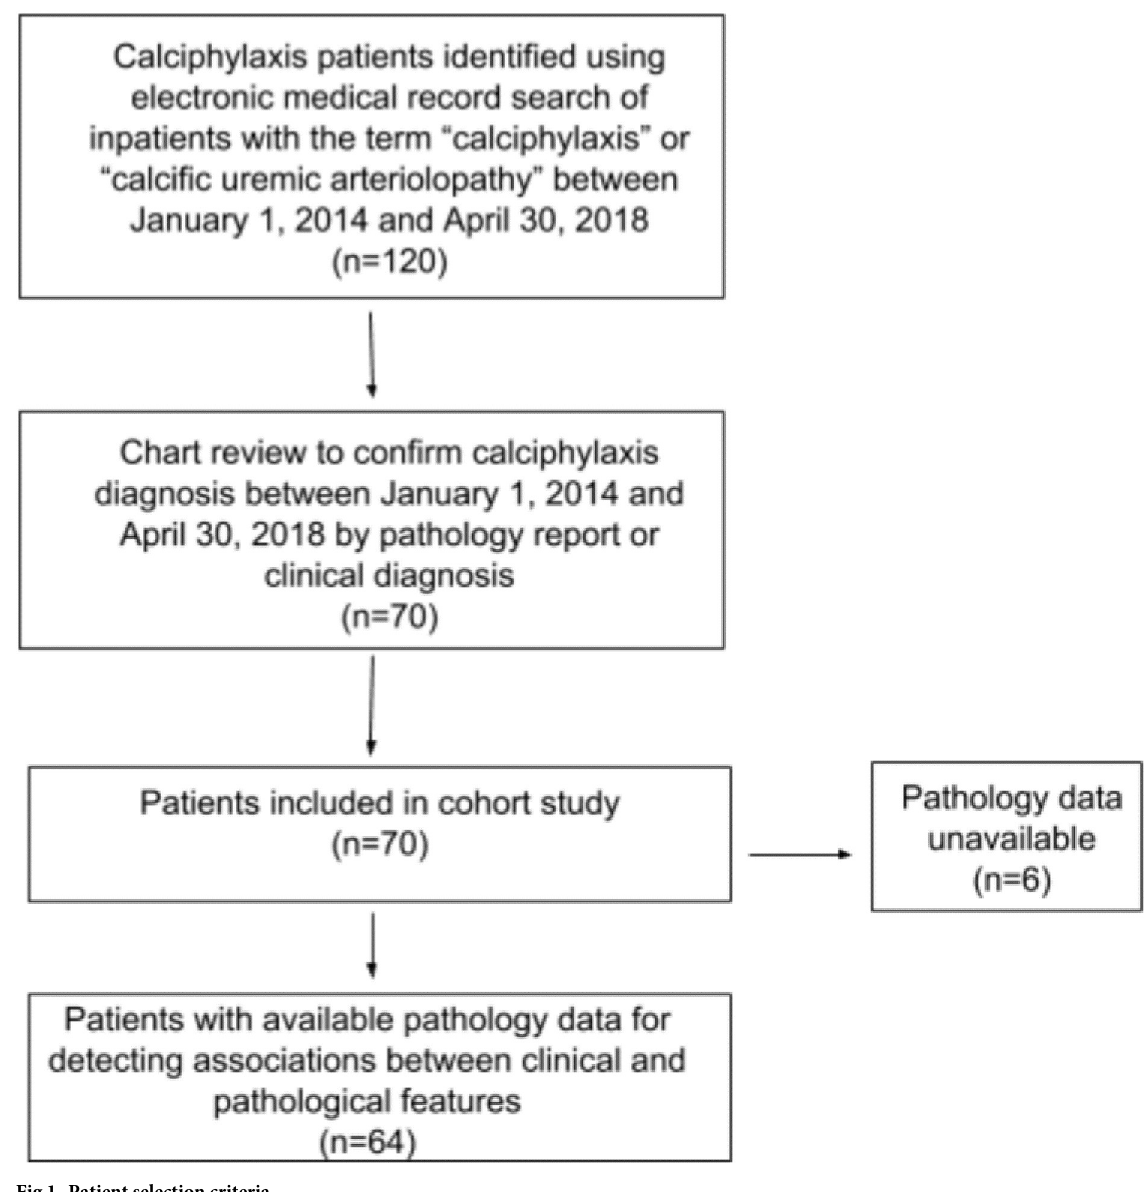
Fig 1. Patient selection